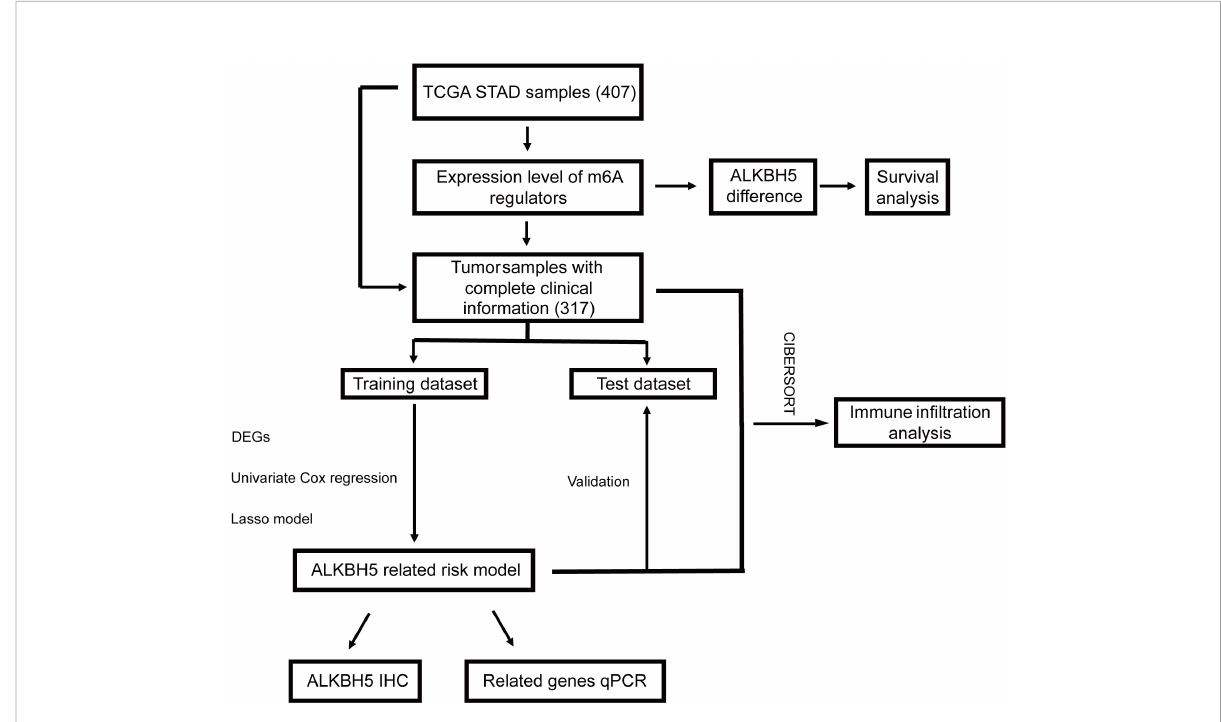
FIGURE 1 Work fl ow chart of our study. STAD, stomach